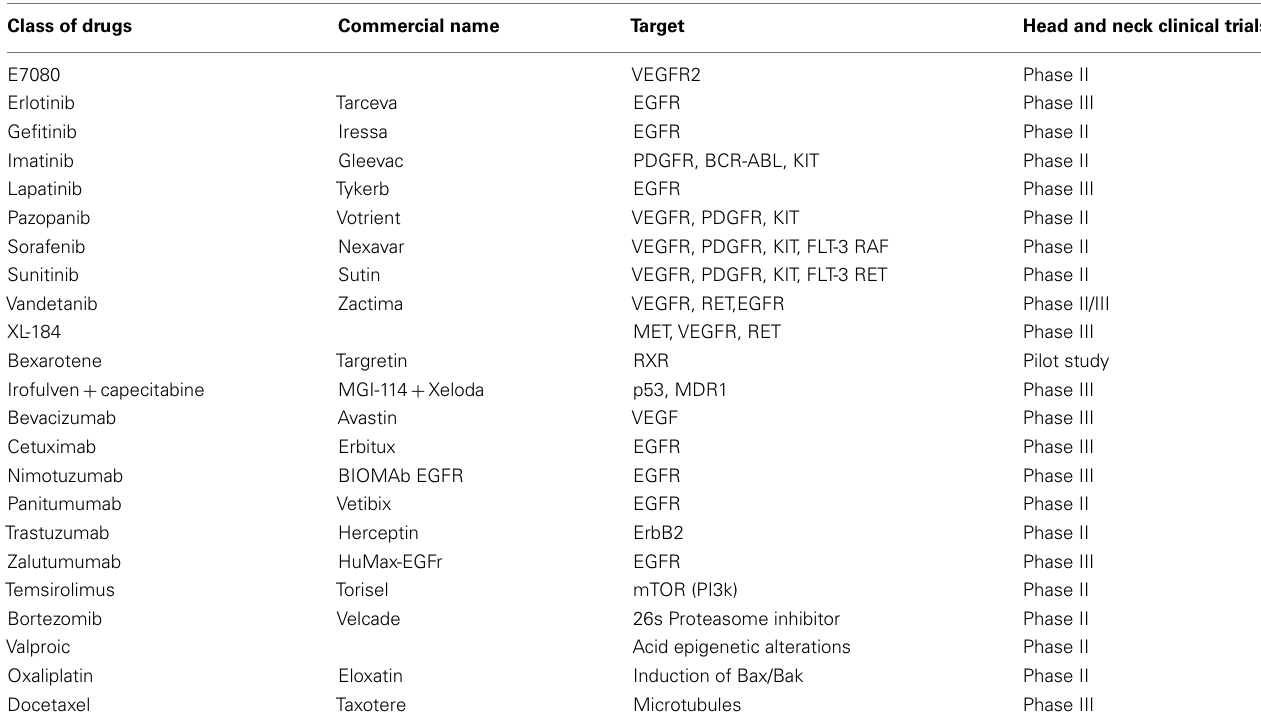
Table 1 | Recent drugs, targets, and clinical trials in head and neck